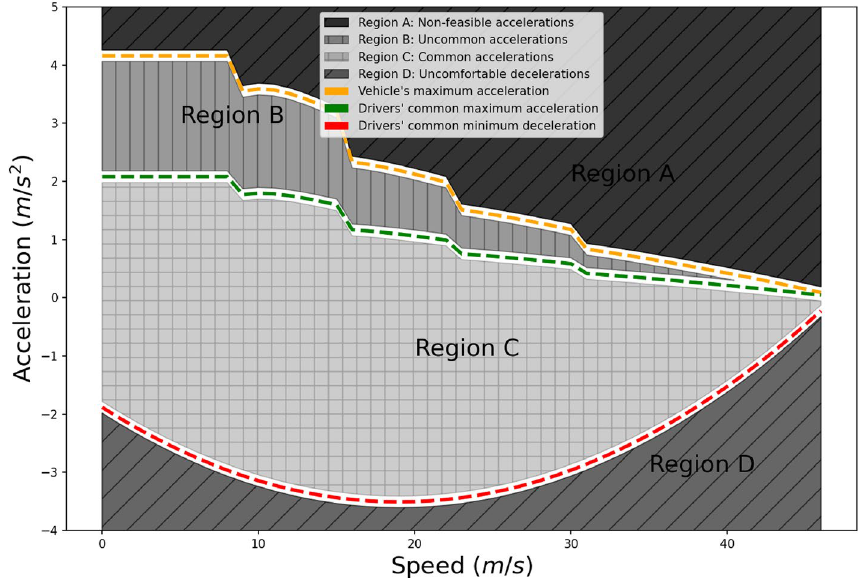
Figure 5. The acceleration-speed domain for a given vehicle and an average driver as computed in 25,36